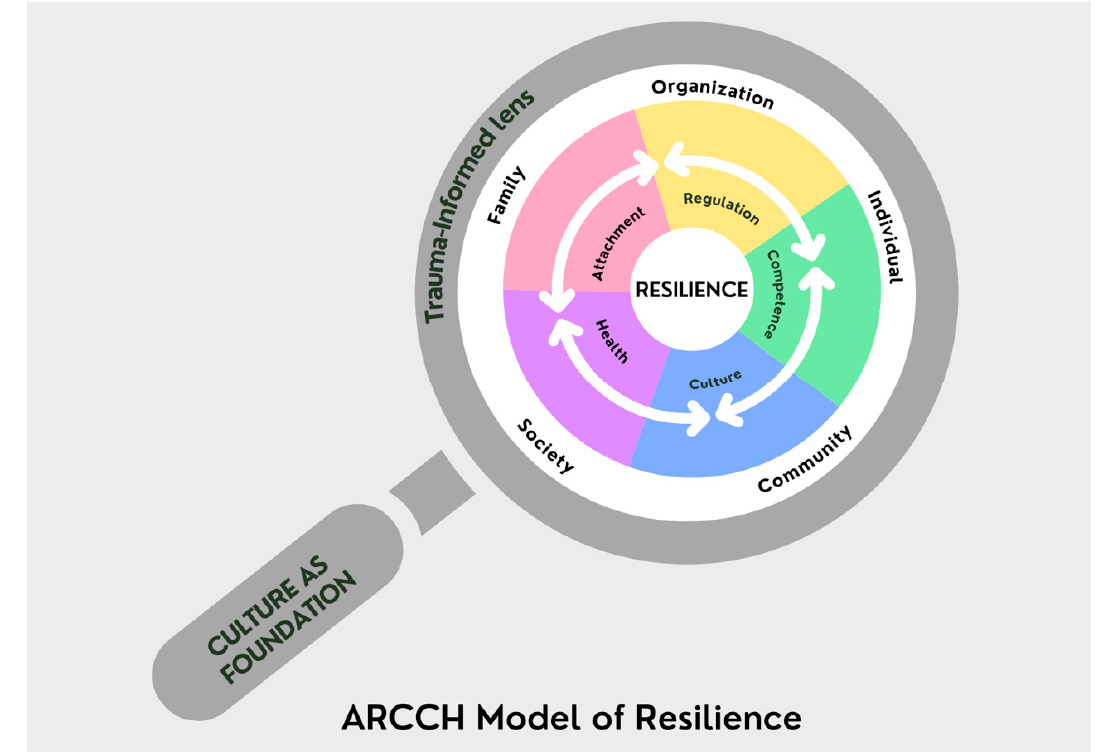
Figure 1. The ARCCH Model of Resilience: A Flexible Multisystemic Resilience Framework. In this